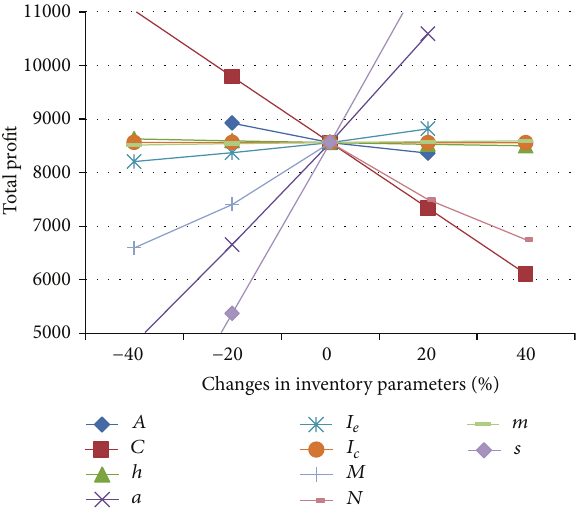
Figure 2: Concavity of total profit with respect to cycle time 𝑇 for 𝑀 < 𝑇 + 𝑁 .